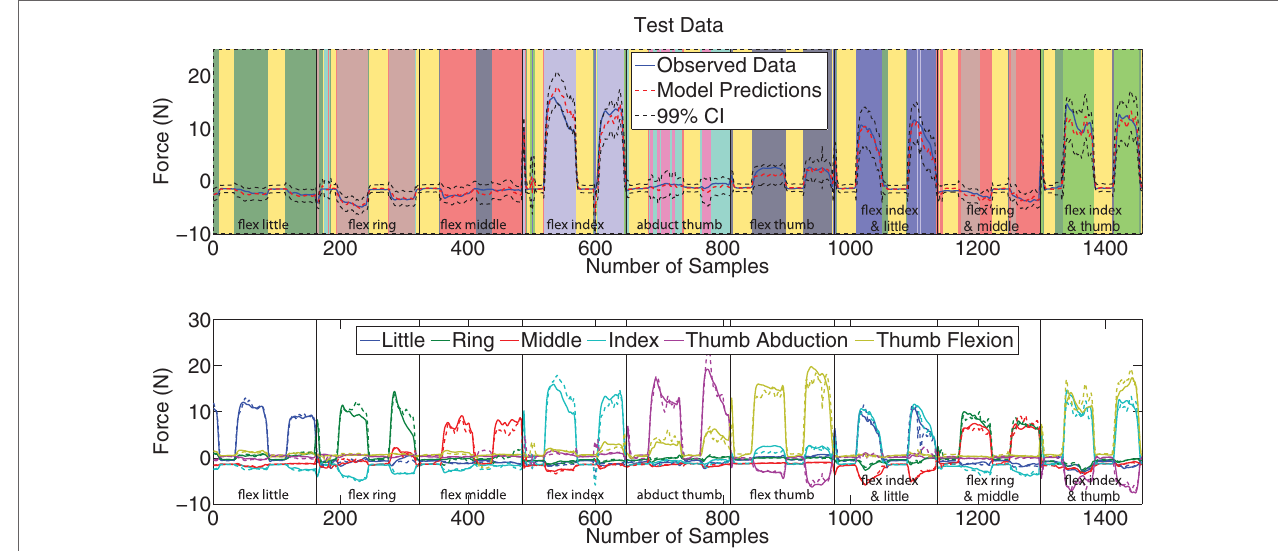
FIGURE 6 | Top plot: Predictions (red) versus observed data (blue) including 99% confidence intervals (dashed black) on the test data of the fourth DoF force activation. The background of colors represents the individual experts, and black vertical line indicates when a movement starts. Bottom plot: A plot of observed (solid) and predicted (dashed) forces for the second and fifth repetitions of all nine force patterns. Each box represents a force pattern, and each color corresponds to a force measurement.